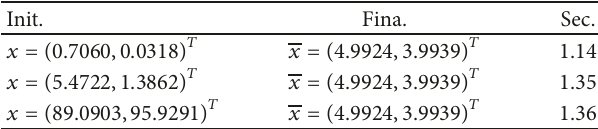
Table 1: The final value and the cpu time for different initial points.